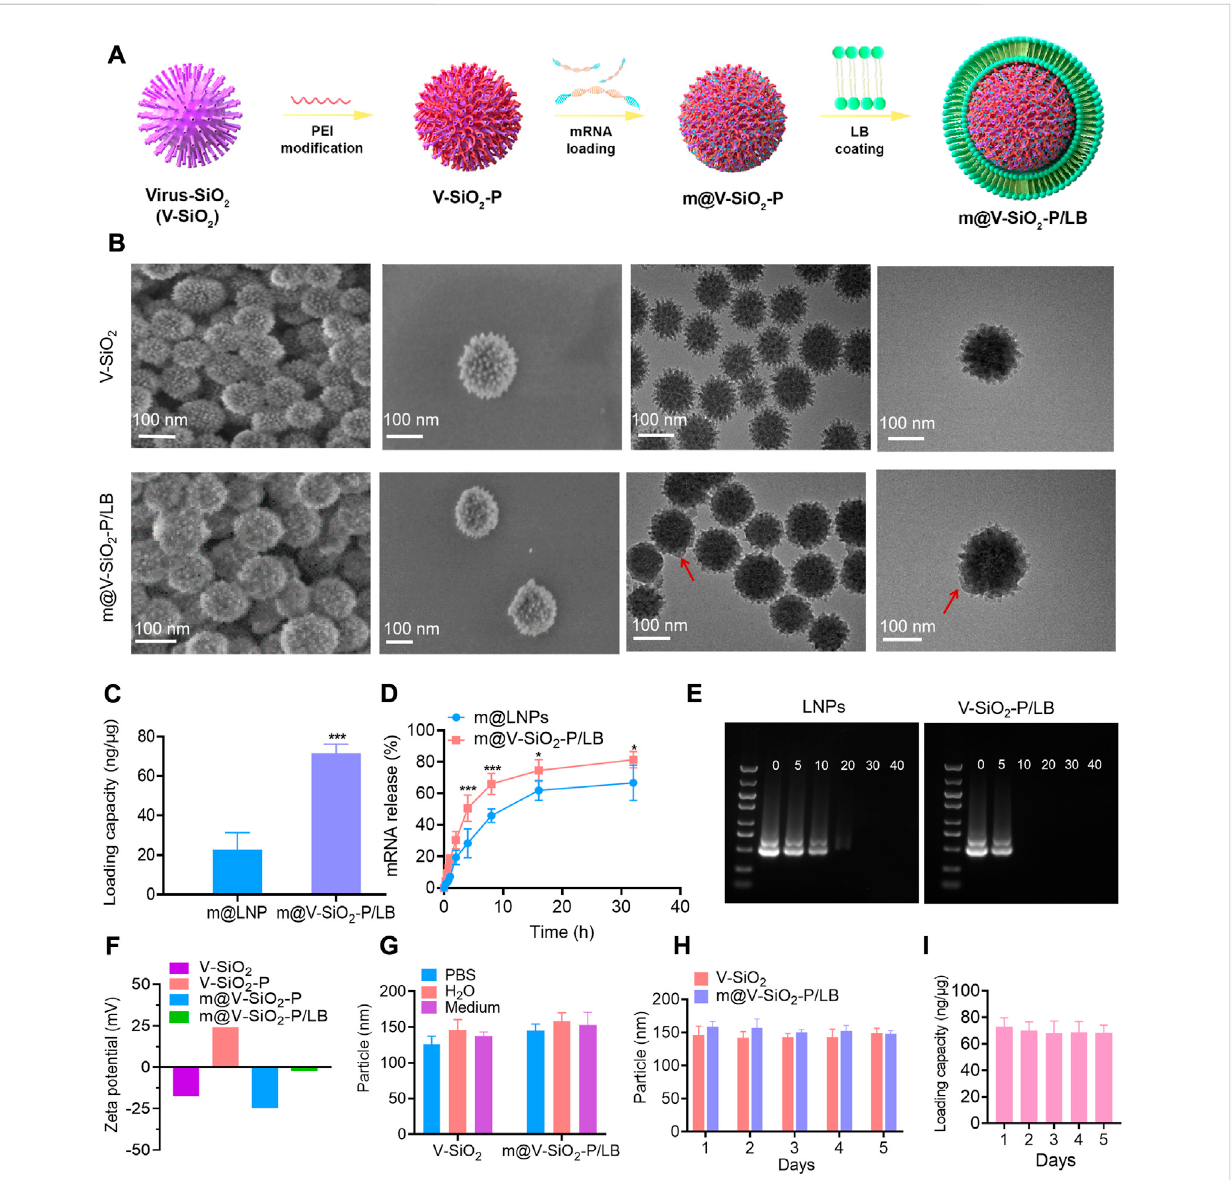
FIGURE 2 Theoptimaldesignandcharacterizationofm@V-SiO 2 -P/LBnanoparticles. (A) AnillustrationoftheV-SiO 2 -P/LBnanotopographyforprecisemRNA delivery. (B) Structural characterization of V-SiO 2 and m@V-SiO 2 -P/LB by SEM and TEM. (C) GFP mRNA loading capacities of LNPs and V-SiO 2 -P/LB nanoparticles. (D) Cumulative release of GFP mRNA from LNPs and V-SiO 2 -P/LB nanoparticles at pH 7.4. * p < 0.05, ** p < 0.001. (E) Agarose gel electrophoresisoftheGFPmRNA-LNPs andGFPm@V-SiO 2 -P/LBcomplexes,respectively. Theamounts ofLNPsand V-SiO 2 -P/LBvariedfrom 0to 40 μ g, while the amount of mRNA was kept at a constant (0.5 μ g). (F) Zeta potentials of V-SiO 2 and PEI-V-SiO 2 (V-SiO 2 -P), GFP mRNA loading, and LB coating. (G) Size distribution analysis of V-SiO 2 and m@V-SiO 2 -P/LB nanoparticles dispersed in water, PBS and cell culture medium for 24 h. (H) Particle size distribution curves of V-SiO 2 and V-SiO 2 -P/LB nanoparticles after suspension in PBS for 1, 2, 3, 4, and 5 days measured by DLS. (I) mRNA loading